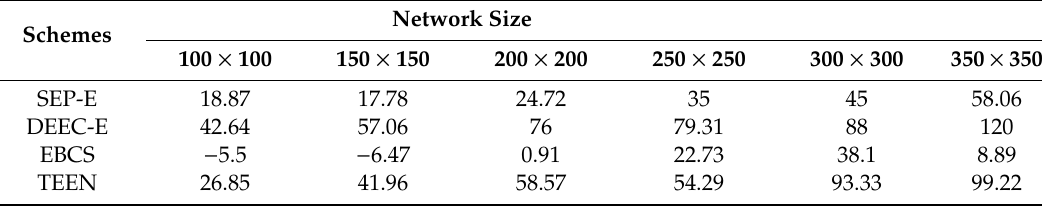
Table 12. Percentage improvement of HFECS in terms of network lifetime (FND).